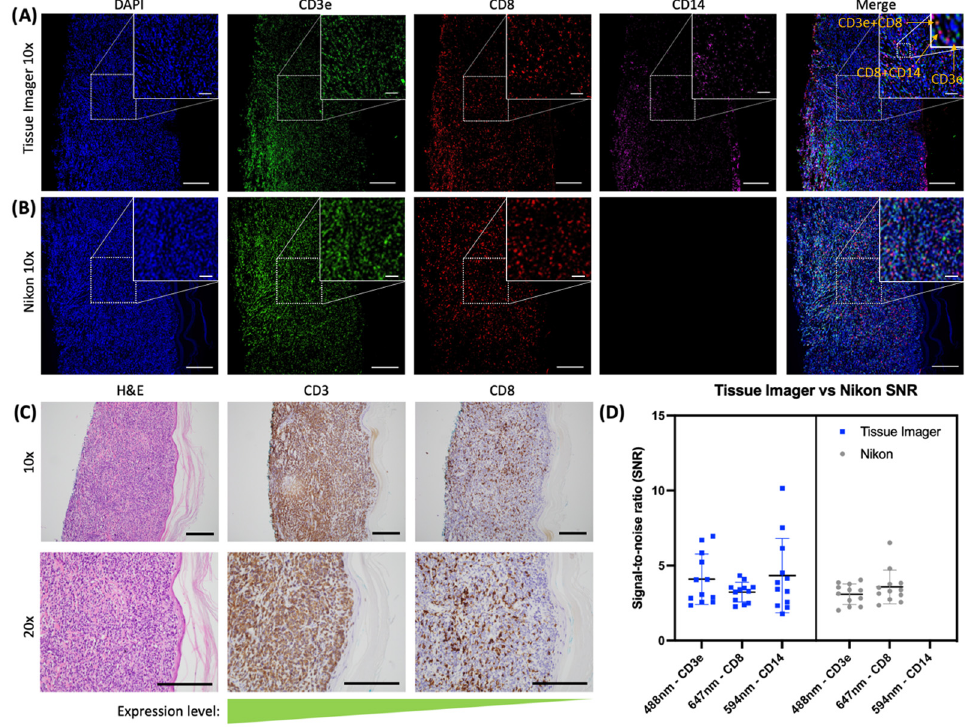
Figure 4. A 4-plex immune panel on CTCL with comparison to IHC and Nikon microscope. A 4-plex immune panel on CTCL with comparison to IHC and Nikon microscope. Immunofluorescence staining of DAPI, CD3e, CD8, and CD14 on Cutaneous T-cell Lymphoma (CTCL) FFPE tissue sec- tions imaged with the Tissue Imager and Nikon. Images were compared to H&E staining, CD3 IHC, and CD8 IHC of serial sections. ( A ) Tissue Imager 10x images cropped for channels (DAPI, CD3e, CD8, CD14) and merged. Example protein puncta are indicated by arrows in the merged image. ( B ) Nikon Ti-1000E 10× images for channels (DAPI, CD3e, CD8) and merged. ( C ) 10× and 20× images of H&E, CD3 IHC, and CD8 IHC staining on serial sections of CTCL FFPE tissue sections. Brown stain- ing is a positive signal. D) Signal-to-noise ratio (SNR) comparison between Tissue Imager and Nikon images for each channel ( n = 12). Sca tt er plots were plo tt ed with mean and standard deviation. A student t -test was performed for the 488 nm channel between the Tissue Imager and Nikon Ti-1000E had a p value of >0.11 (n.s.). Scale bars, 200 µm for large images and 50 µm for insets. After acquisition, the images were processed using ImageJ and analyzed using a Cell- Pro fi ler [32,33] image analysis pipeline (Figure 5A). The CellPro fi ler pipeline was vali- dated by manually counting six 700 × 700 px regions of interest that were randomly se- lected throughout the tissue section. The manual counting was used to obtain the percent- age of cells positive for each marker and compared to the counts detected in the CellPro- fi ler pipeline. As shown in Supplementary Figure S6, there were no signi fi cant di ff erences between the manual counts and CellPro fi ler counts for all three markers (CD3e, CD8, and CD14). By detecting the DAPI-stained nuclei, 8238 cells were found in this image (Figure 5B). The cells positive for each marker were then detected and quanti fi ed, with 51% of cells expressing CD3e, 16% of cells expressing CD8, and 18% of cells expressing CD14 (Figure 5C). The percentages of cells positive for each marker were then plo tt ed for all images (n = 7), resulting in an average of 49%, 15%, and 12% cells positive for CD3e, CD8, and CD14, respectively (Figure 5D). The CellPro fi ler pipeline also detected cells that co- expressed both CD3e and CD8. On average, 9% of cells were CD3e/CD8-positive, 40% of cells were CD3e-positive/CD8-negative, and 5.7% of cells were CD3e-negative/CD8-positive (Fig- ure 5E).